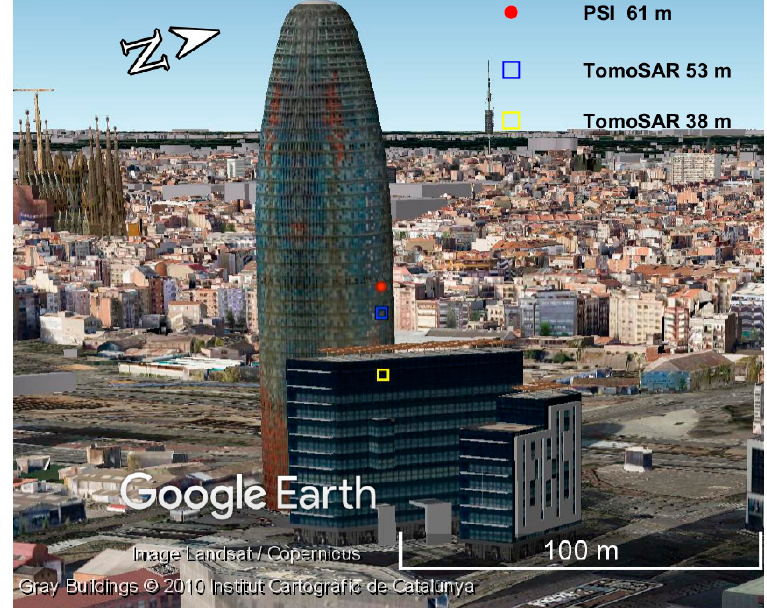
Figure 10. Difference in height estimate between TomoSAR and PSI in a common point.